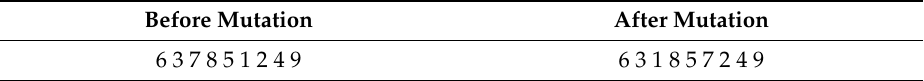
Table 3. Examples of mutation operations.